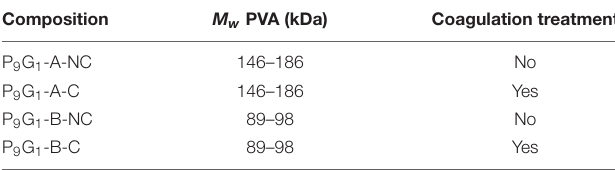
fitted to polynomial (35), reduced polynomial (36) and Ogden (37) models for the simulation of coronary artery